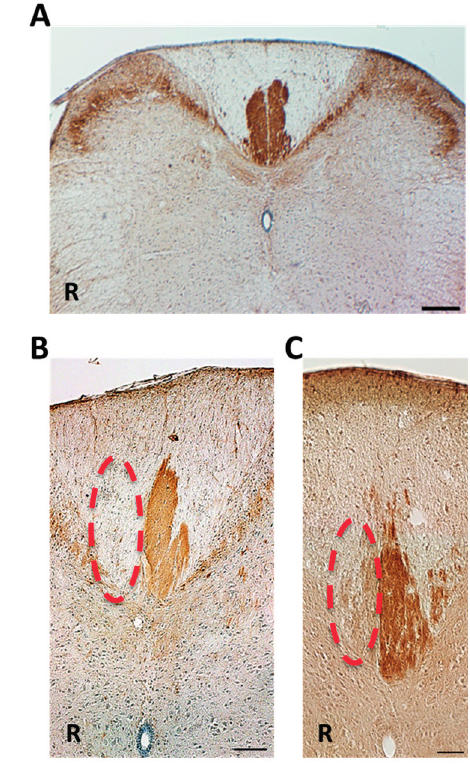
Figure 2. Protein kinase C- γ (PKC γ ) immunohistochemistry. ( A ) Normal adult